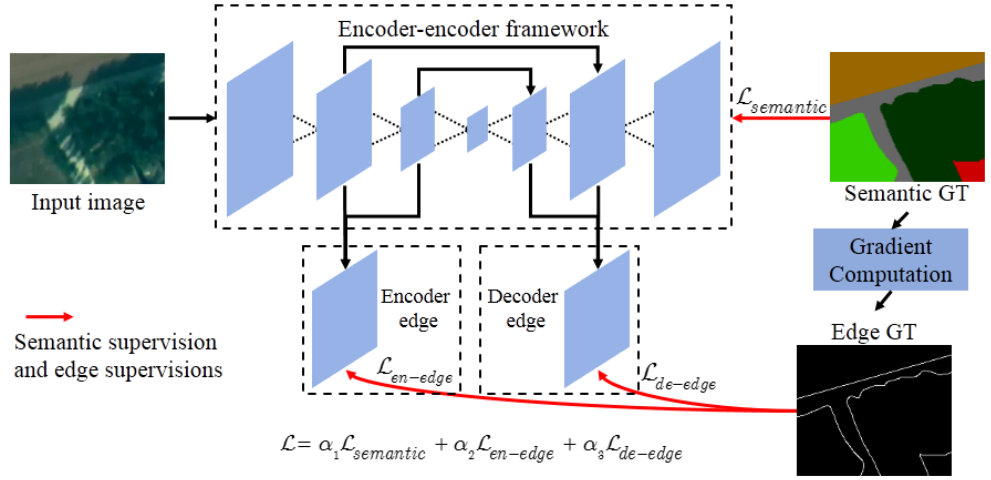
Figure 2. Framework of the proposed edge loss reinforced semantic segmentation network (ERN). The encoder edge and decoder edge are constructed to promote the semantic segmentation. In the training phase, the semantic ground truth (GT) and edge ground truth simultaneously provide the supervision information in different layers. Thus, the loss ( L ) of the network includes semantic loss ( L semantic ) and edge loss ( L en − edge , L de − edge